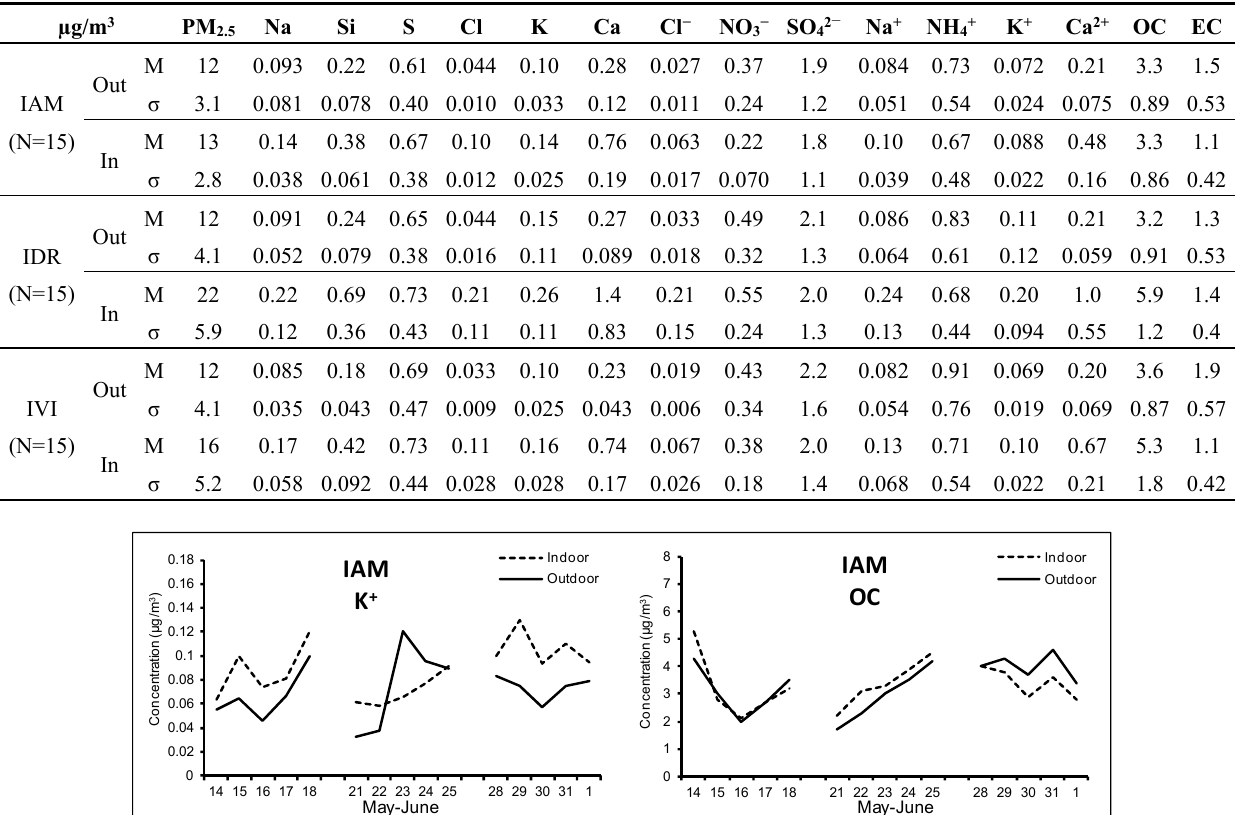
Table 2. Mean value (M) and standard deviation ( σ ) of the main chemical components measured indoor and outdoor during the spring/summer period.